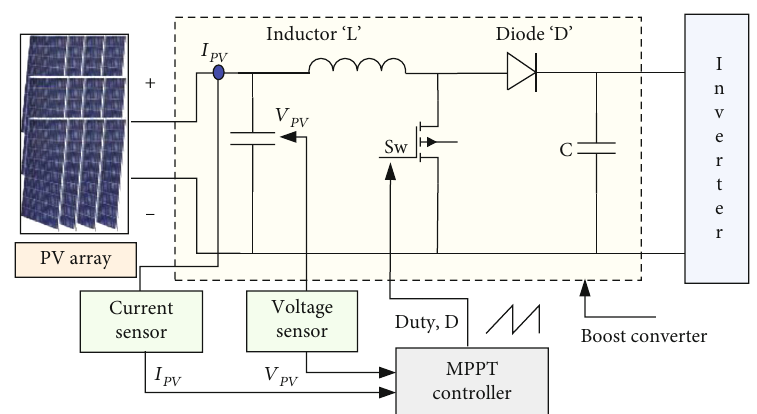
Figure 3: Representation of DC-DC boost